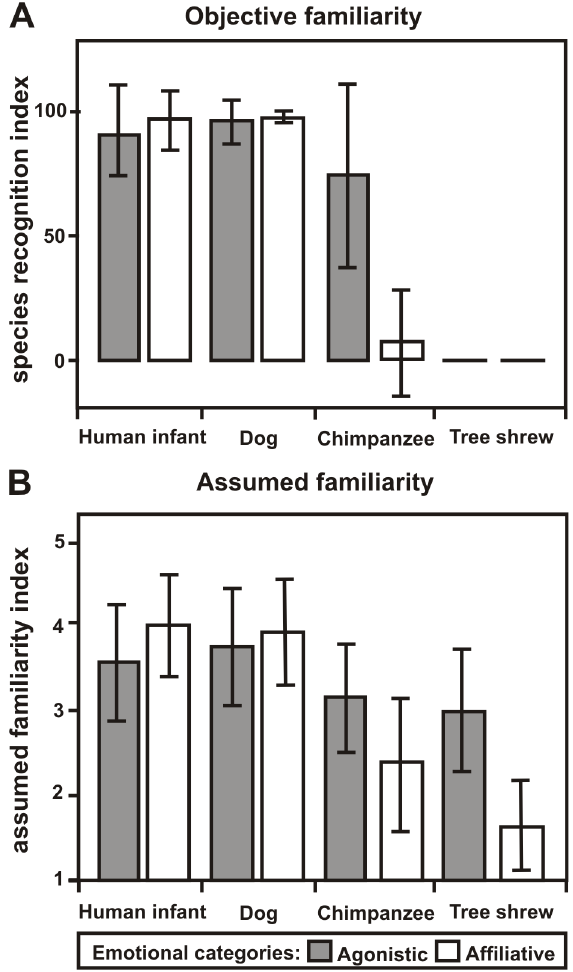
Figure 2. Familiarity ratings for the playback categories. Mean and standard deviation of the (A) species recognition index and the (B) assumed familiarity index for each playback category.